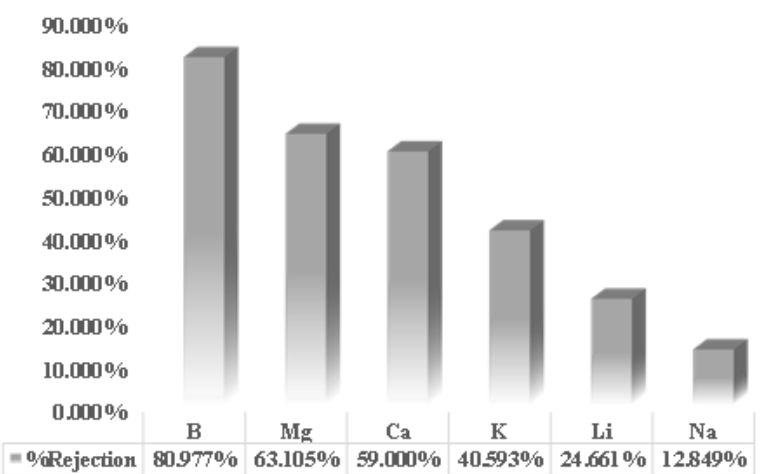
Figure 4. The percentage of rejection of several ions from research results with variations in the operating voltage.